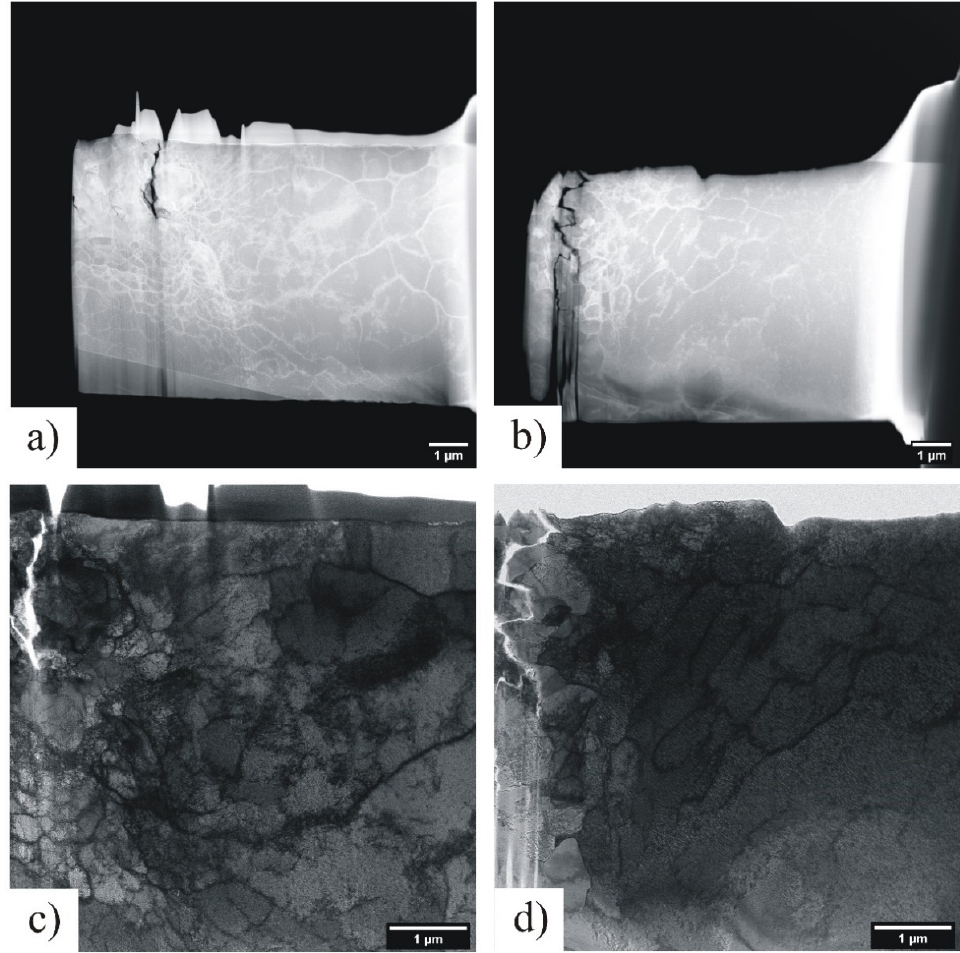
Figure 9. TEM results of X2-12: ( a ) And ( b ) are overview STEM images showing the position of the crack tip for ( a ) the reference and ( b ) the precharged condition; ( c ) and ( d ) are corresponding TEM bright-field images at higher magnification documenting dislocation cells.